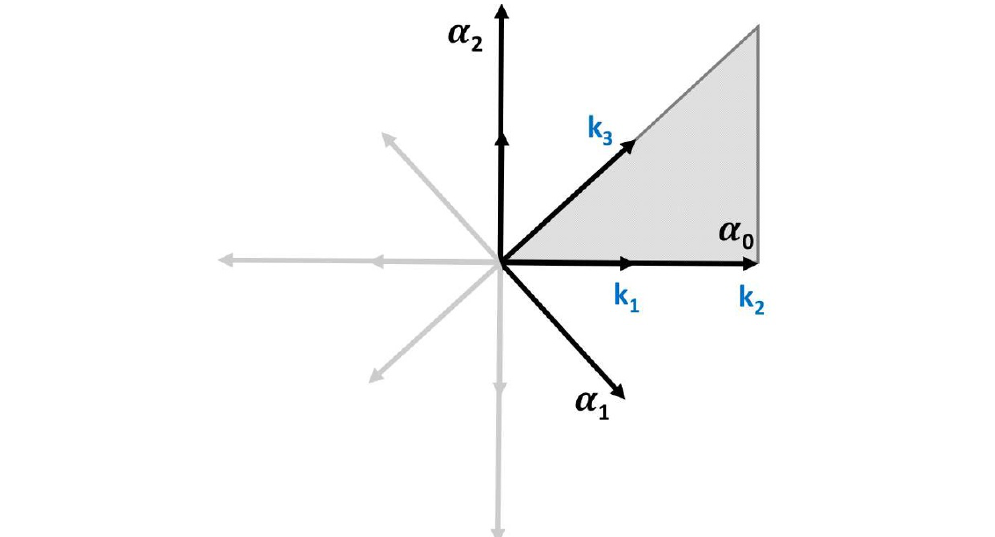
Figure 2 . The BC 2 root system. The set Σ + of positive roots in shown in bold black arrows. For N > 1 there are three different types of roots that belong to three different orbits of the Weyl group W N . These carry multiplicity k α . Our basis elements α 1 and α 2 are also depicted along with the highest root α 0 = 2 α 1 + α 2 = 2 e 1 . The linear spaces that are fixed under the Weyl reflections w 1 and w 2 that are associated with α 1 and α 2 form the boundary of the Weyl chamber (shown in